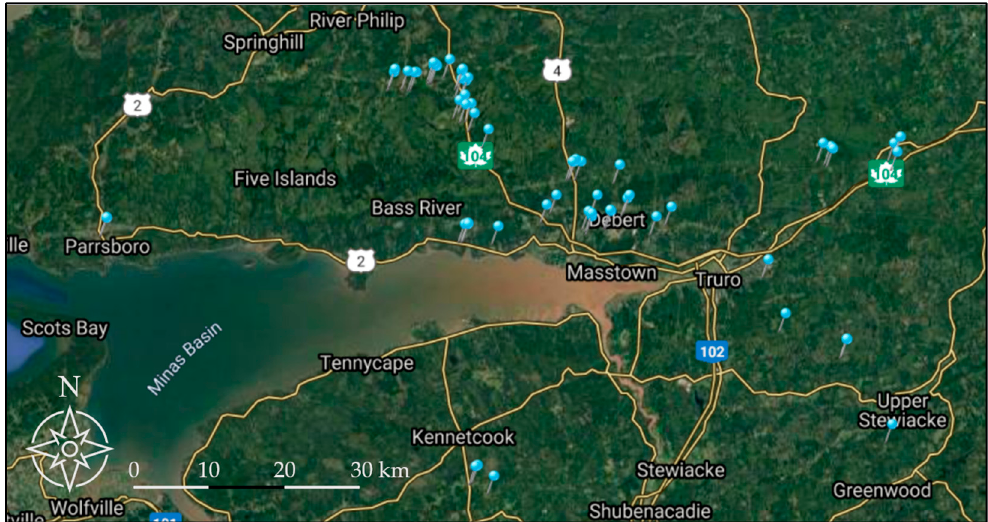
Figure 1. Map of image collection sites in Nova Scotia, Canada. Images were collected in 58 different fields to ensure variability of the dataset (adapted from [52]) .